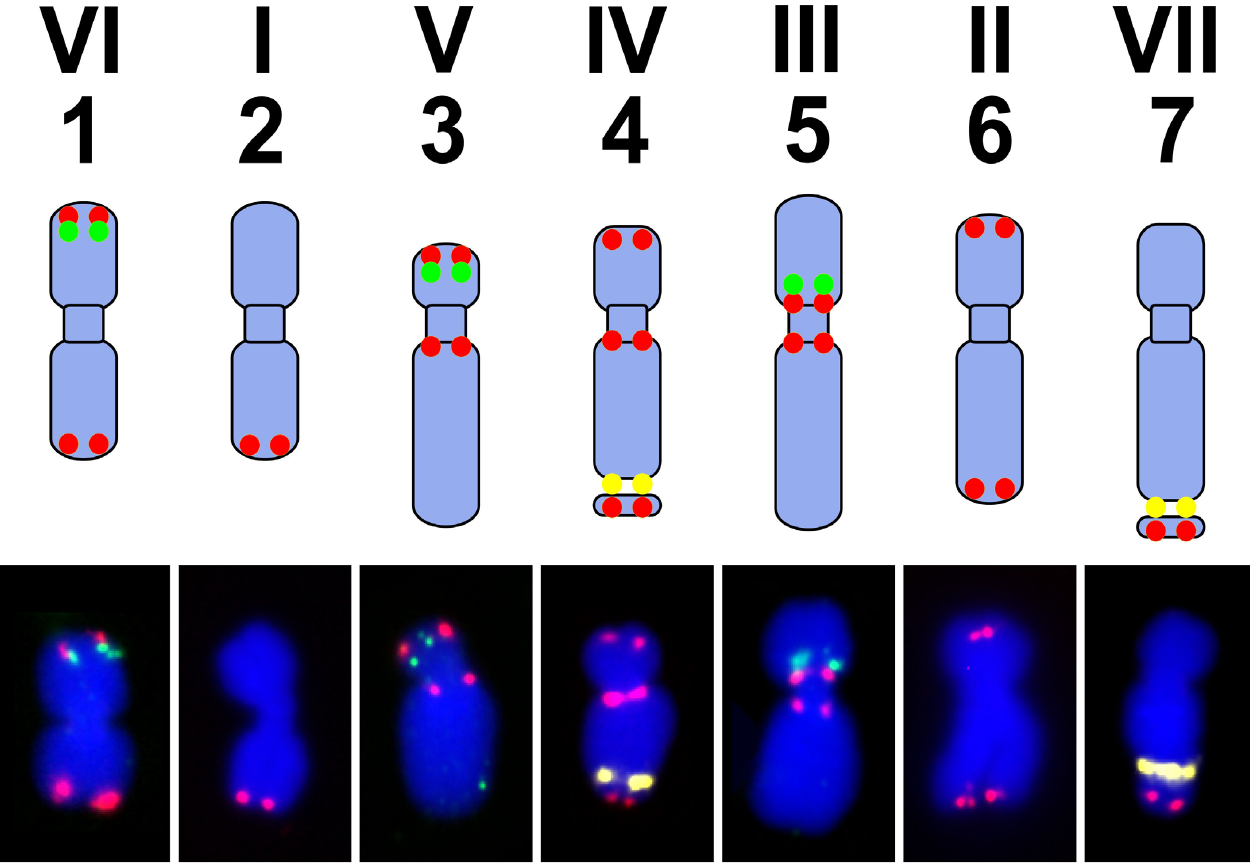
Figure 2. The pea karyotype. Arabic and Roman numerals refer to chromosome type and linkage group, respectively, as assigned by Neumann et al. 2002 [84] and Fuchs et al. 1998 [90]. The upper panel shows a scheme of the pea karyotype with the loci for PisTR-B (red), 5S rDNA (green), and 45S rDNA (yellow). The bottom panel shows the same loci detected by FISH on isolated metaphase chromosomes. Bar = 5